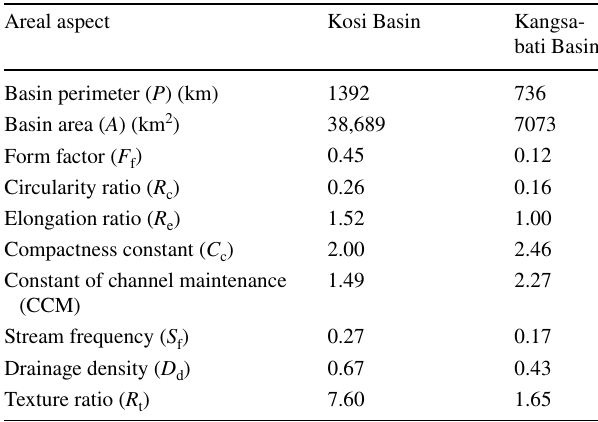
Table 4 Relief morphometric aspects of River